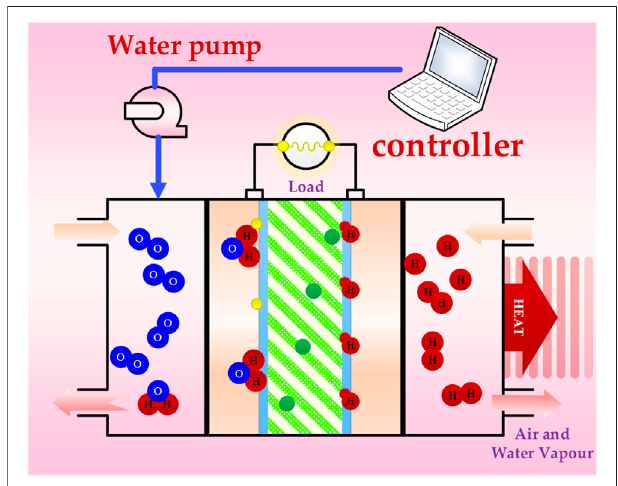
FIGURE 1 | PEMFC control